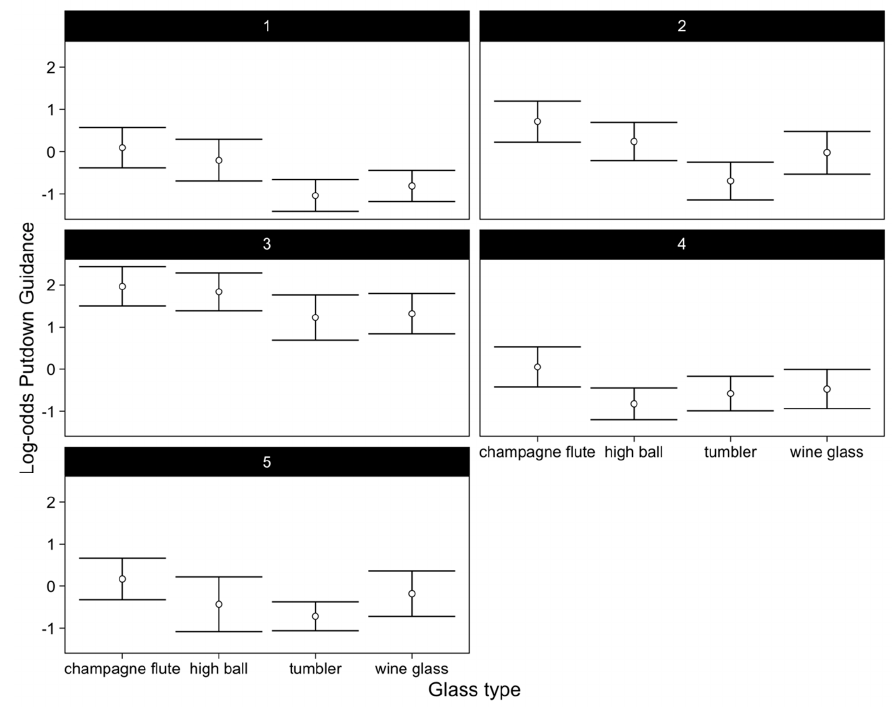
Figure A1. Log-odds plots of putdown 1 guidance (higher values mean the vessel was more likely to be guided during putdown), with 95% CI across glass types, with panels representing each participant.